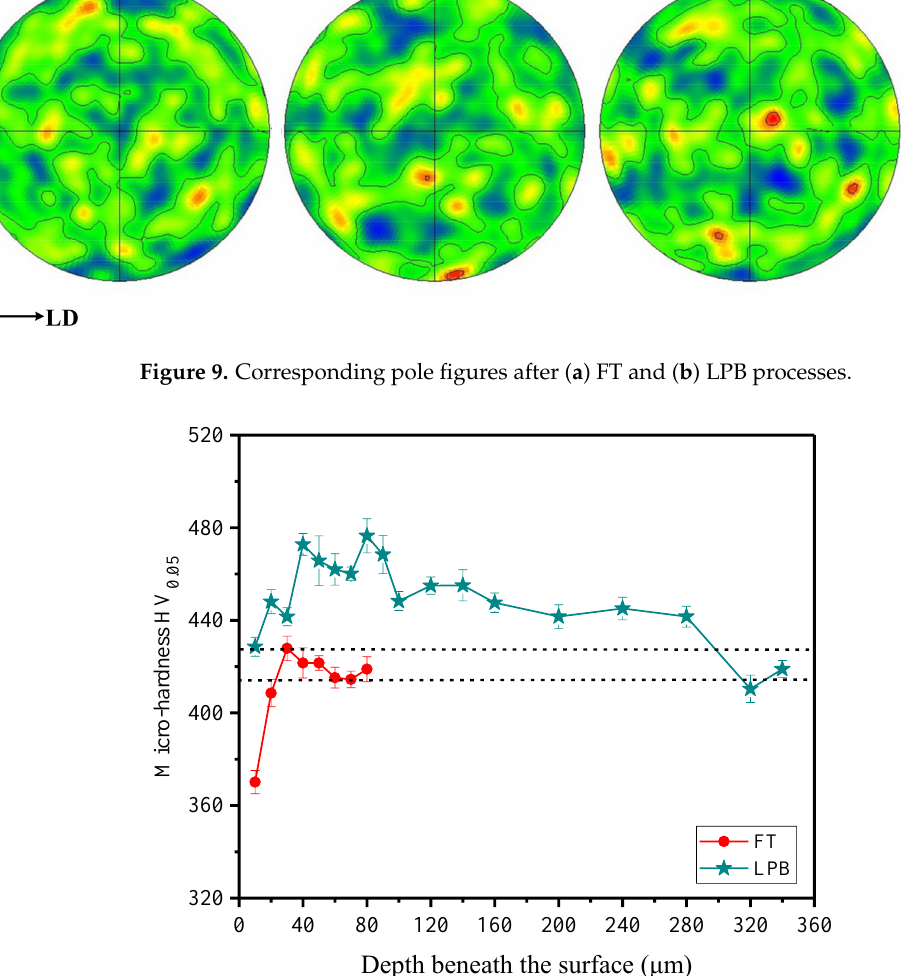
Figure 11. Residual stresses distribution in depth beneath the surface in ( a ) longitudinal and ( b ) transverse directions. The peak compressive residual stress for the FT specimen is − 217 MPa at the depth of 25 μm. After LPB, the peak comp ressive stress reaches −1 136 MPa, which is increased by a factor of 4.2 compared with FT. It is noteworthy that the peak compressive residual stress for LPB specimen is 91% of σ 0.2 . Klotz et al. [36] proposed that the peak compressive residual stress occur red at the depth of 20 μm, and the peak value was 88% of σ 0.2 after shot-peened Inconel 718. It is indicated that LPB induces the higher peak compressive